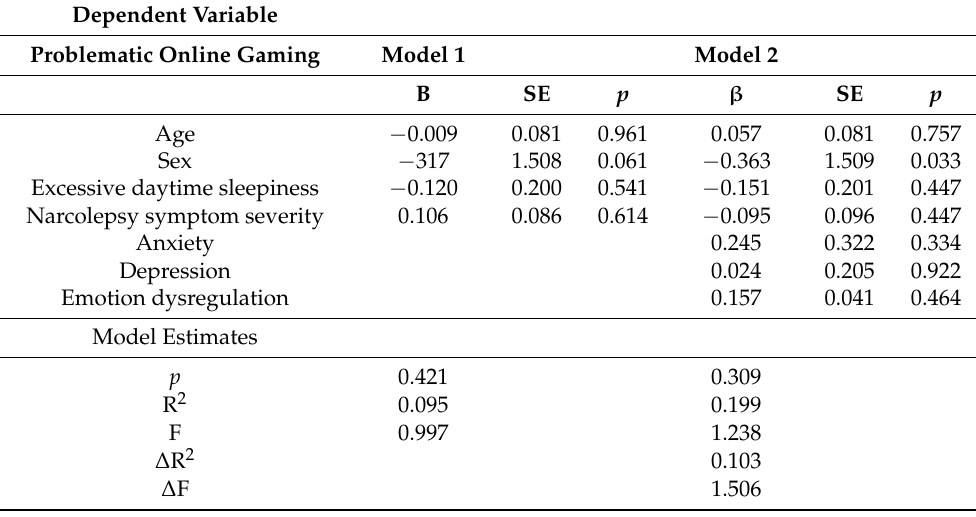
Table 5. Hierarchical multiple regression predicting problematic online gaming